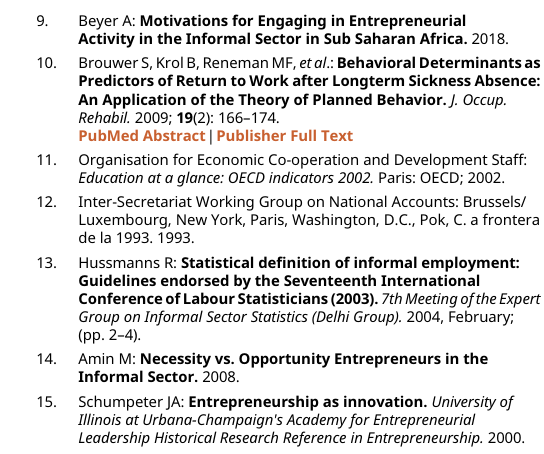
This project contains the following underlying